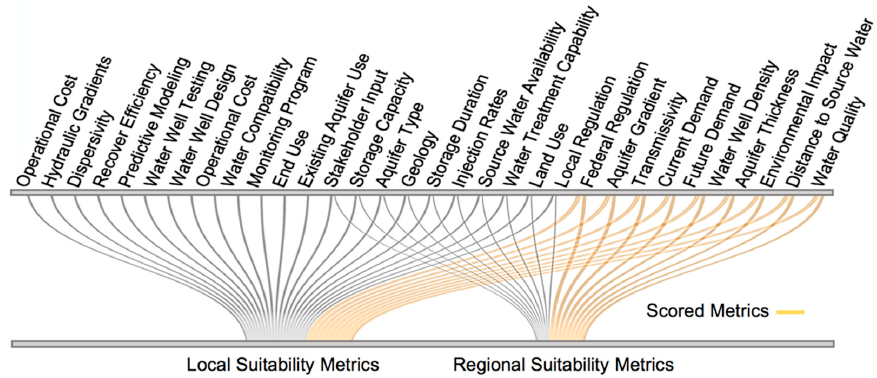
Figure 3. Aquifer storage and recovery (ASR) metrics based on local and regional assessments. Scored metrics from both were applied in this study.